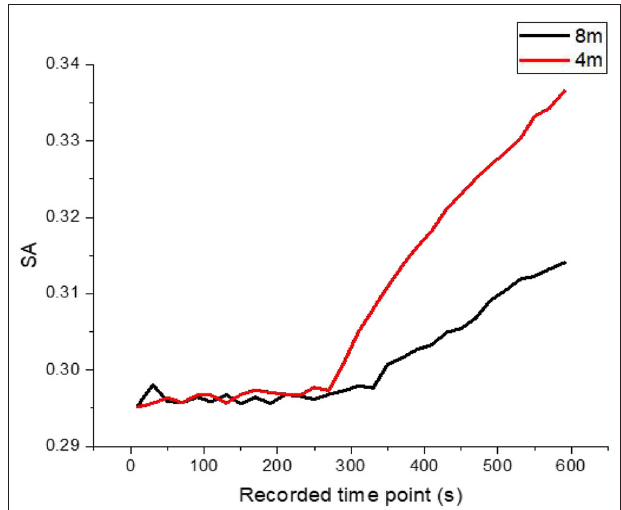
FIGURE 4 | When the road luminance is 3.5, 6.5, and 10 cd/m 2 , the variation trend of average LF/HF ratio of subjects.